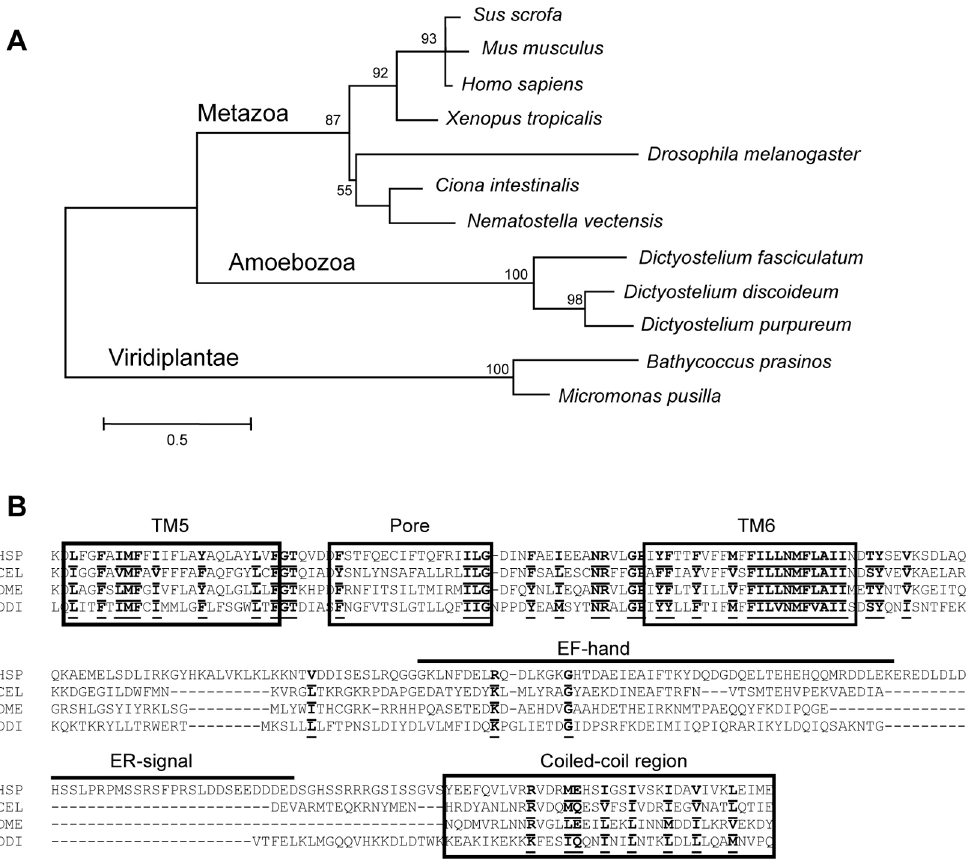
Figure 2. Phylogeny and primary structure of Dictyostelium PKD2. A) Unrooted maximum likelihood tree of the PKD2 family. Branch lengths are proportional to the number of amino acid substitutions. Numbers at the nodes represent the percentage of bootstrap support (only values . 50% are shown). B) Protein alignment of the conserved C-terminal region, spanning TM domains 5 and 6, the pore and coiled-coil regions (boxed). Two other features, only present in the human ortholog, are also indicated: the EF-hand domain and a region essential for endoplasmic